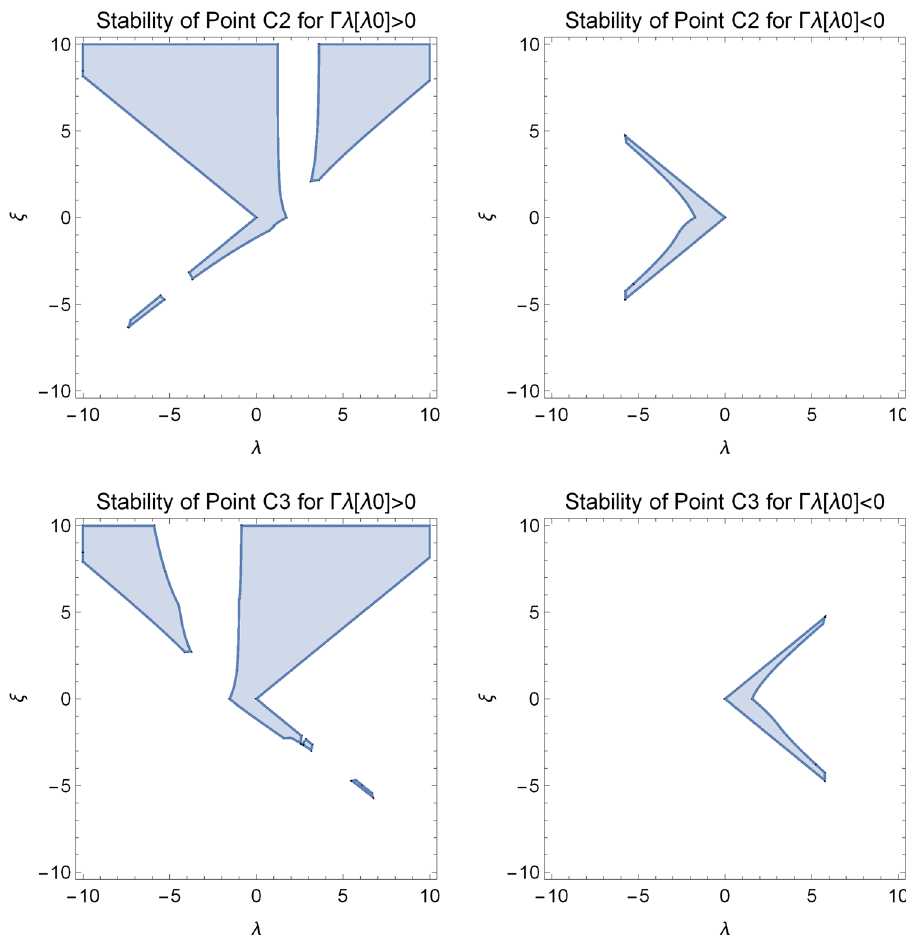
Fig. 11 Region plots for the variables { λ,ξ (λ) } in which points ¯ C 2 and ¯ C 3 are